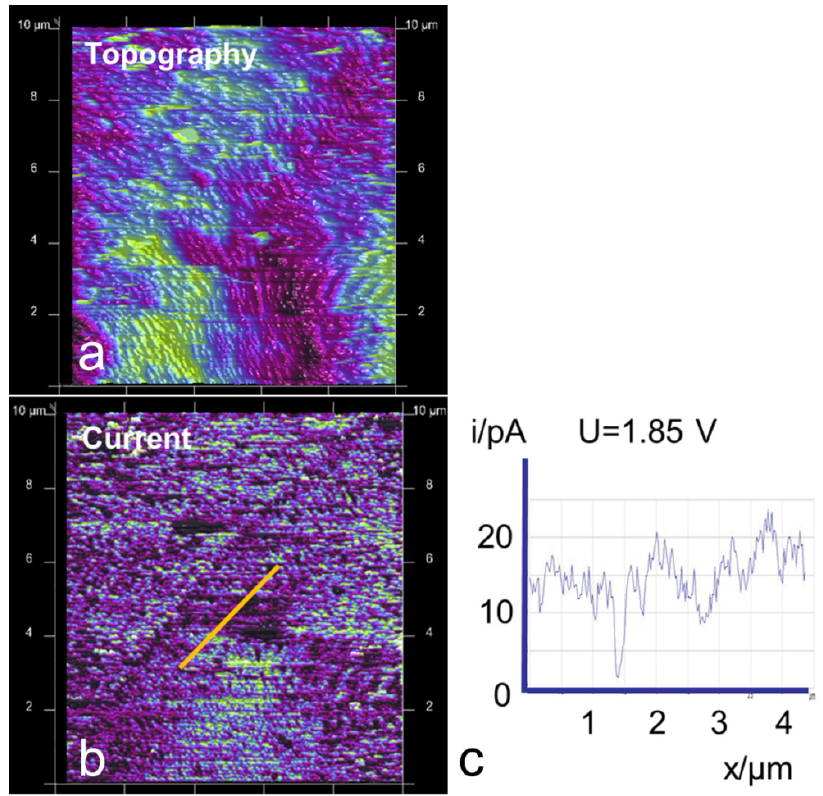
Figure 4. ( a ) AFM image of Nafion ® 112 before activation with a lamellar surface structure; differently orientated domains are visible; image size 10 µm × 10 µm. ( b ) Map of ionic current at the same area at U = 1.85 V. ( c ) The current profile measured along the marked line in the current image shows small current values, of the order of 10–20